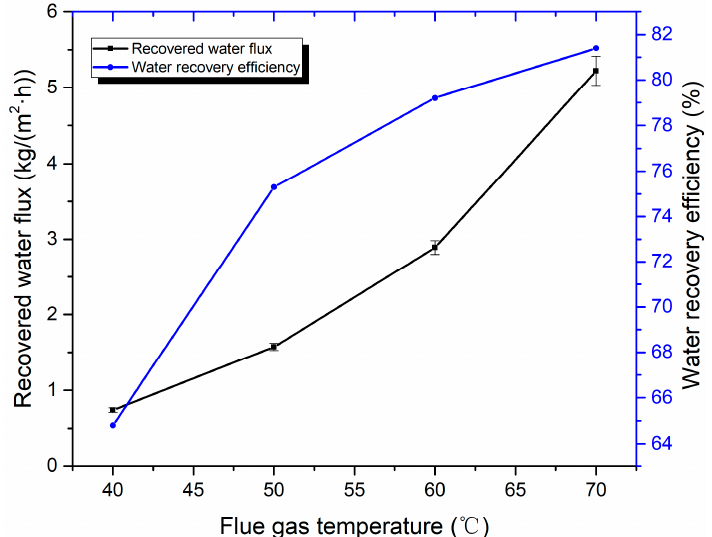
Figure 13. Effect of flue gas temperature on water recovery performance (Experiment conditions: flue gas flow 9 L/min, cooling water flow rate 1 L/min, and cooling water temperature of 20 °C).